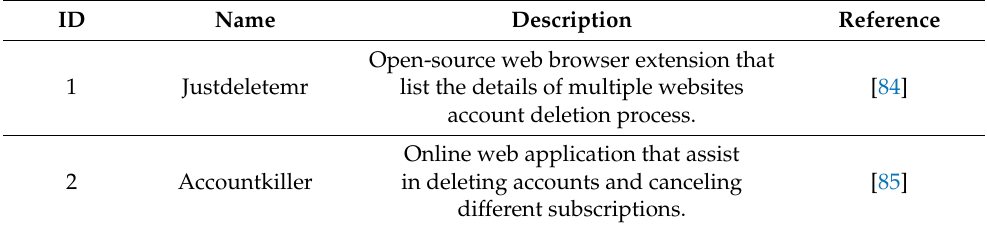
Table 19. Tools used digital finger print cleanup.